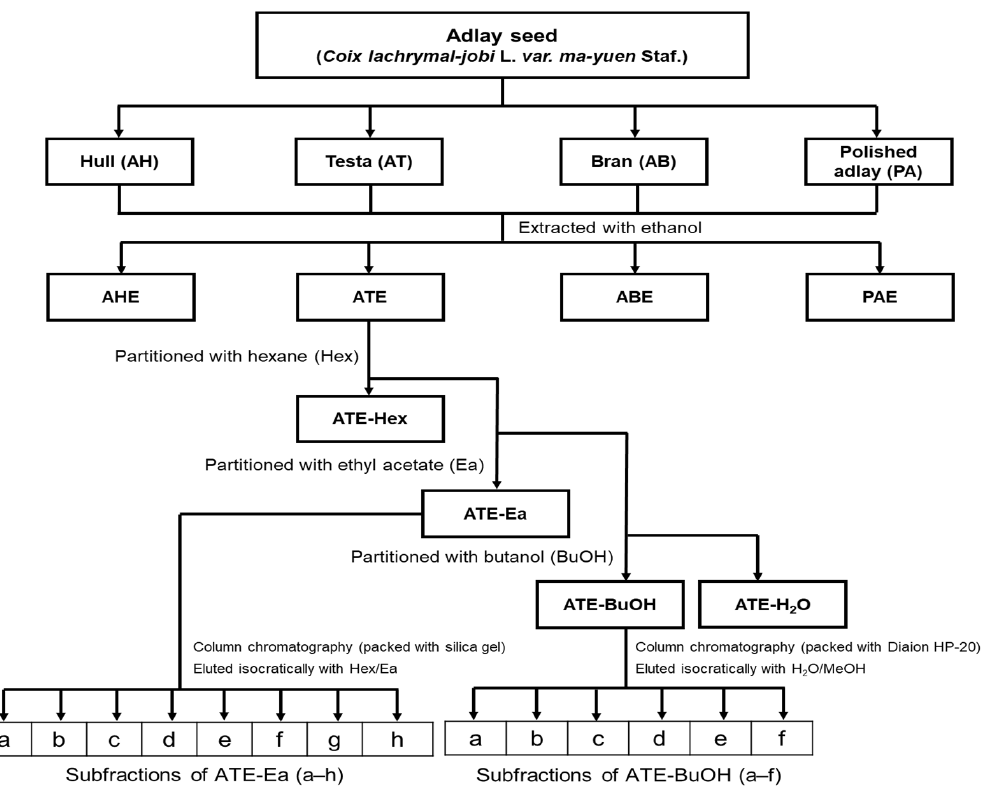
Figure 1. Partitioning scheme for preparing and isolating active fractions and components from adlay ethanolic extracts. ATE-Ea was dissolved in Ea and subjected to column chromatography on a silica gel with a Hex/Ea gradient from 0 to 100% EA (every 10%) to yield a–h. ATE-BuOH was dissolved in MeOH and subjected to column chromatography on a Diaion HP-20 resin with an H 2 O/MeOH gradient from 0 to 100% MeOH (every 25%)to yield a–f.